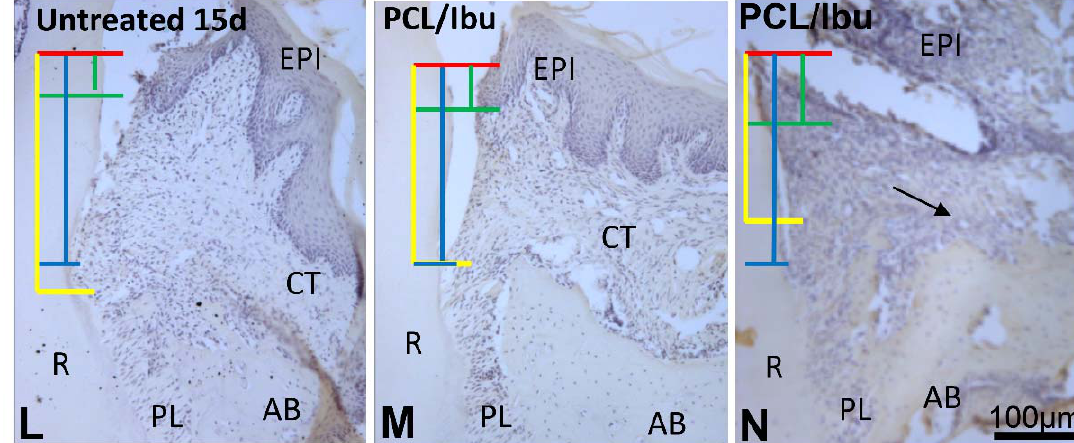
Figure 2. Periodontitis induced with Porphyromonas gingivalis ‐ infected ligatures and treatment with PCL/Ibu membrane ( A – D ). ( B ) sulcular incision along the first and second maxillary molars, ( C ) raising the flaps for exposure and access, ( D ) surgical placement of PCL/Ibu membrane on the periodontal lesion, ( E – N ) histological view at 7 and 15 days. ( E – K ) histology of periodontal wound healing at 7 days and ( L – N ) at 15 days. Red line = cementoenamel junction, blue line = fibrous connective tissue attachment, green line = epithelial attachment, yellow line = bone level. After anesthesia, a slight incision to the bone crest contact was made to facilitate the first ligature placement at the junction between the gum and the tooth along the first and second molars (M1-M2) as previously described [16]. The thread was then blocked with a drop of glass ionomer (Fuji IIGC, GC, France, Bonneuil sur Marne, France). Sterilized black braided 6.0 silk threads (Ethicon, Auneau, France) were incubated in culture medium containing P.gingivalis in an anaerobic chamber for one day. P.gingivalis -soaked ligatures were placed around maxillary first and second molars. The ligatures were inspected and replaced (with freshly infected ones) thrice a week for a period of 40 days. An incision was performed along the sulcular margins of the first and second molars and extended anteriorly on the mesial aspect of the first molar to efficiently raise the flap to gain access. Ibuprofen-functionalized PCL membrane was punched with a 3 mm diameter cutter. The circular pieces of membrane were further divided into half to achieve a size appropriate enough to cover the lesion. The cut membrane was then placed into the periodontal pocket after raising the flap such that the membrane stays flat beneath the flap covering the lesion fully and the necks of the crowns (molars) partially, entering the inter-dental area as well. The flap was nicely repositioned to perform a suture on the flap while maintaining the membrane underneath [16]. AB: alveolar bone, CT: connective tissue, EPI: epithelium, PL: periodontal ligament, R: root. Stars showing PCL/Ibu